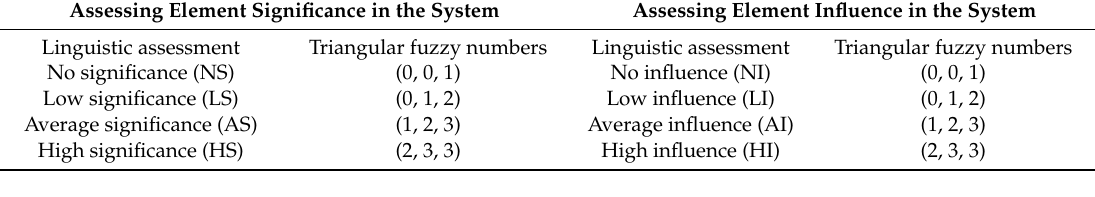
Table 1. Linguistic assessment of element significance and influence and their representation as triangular fuzzy sets, based on [29]. Figure 3. A representation of a linguistic opinion of an expert in the form of a triangular fuzzy set [29].